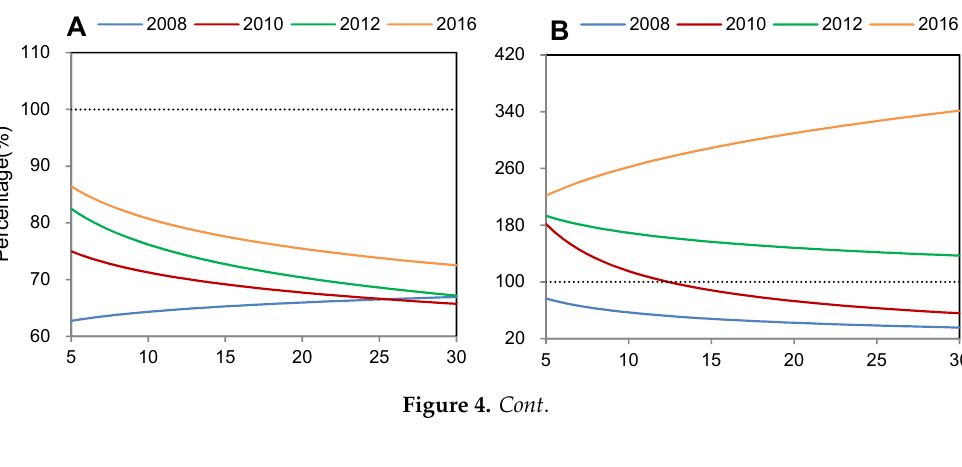
Figure 4. The relationship between the diameter and proportion of calculated biomass of damaged trees to that of calculated biomass of undamaged trees. (A) trunk, (B) branch, (C) leaf and (D) aboveground. 4. Discussion When a disaster, such as ice storm, that causes great damage to the forest occurs, the first things we want to know are how much has been lost, the depth and breadth of its impact, how long it will take to recover, and what to do. The ice storm caused the loss of part of the forest biomass, which in turn caused changes in many ecological processes such as tree growth speed [16,17],